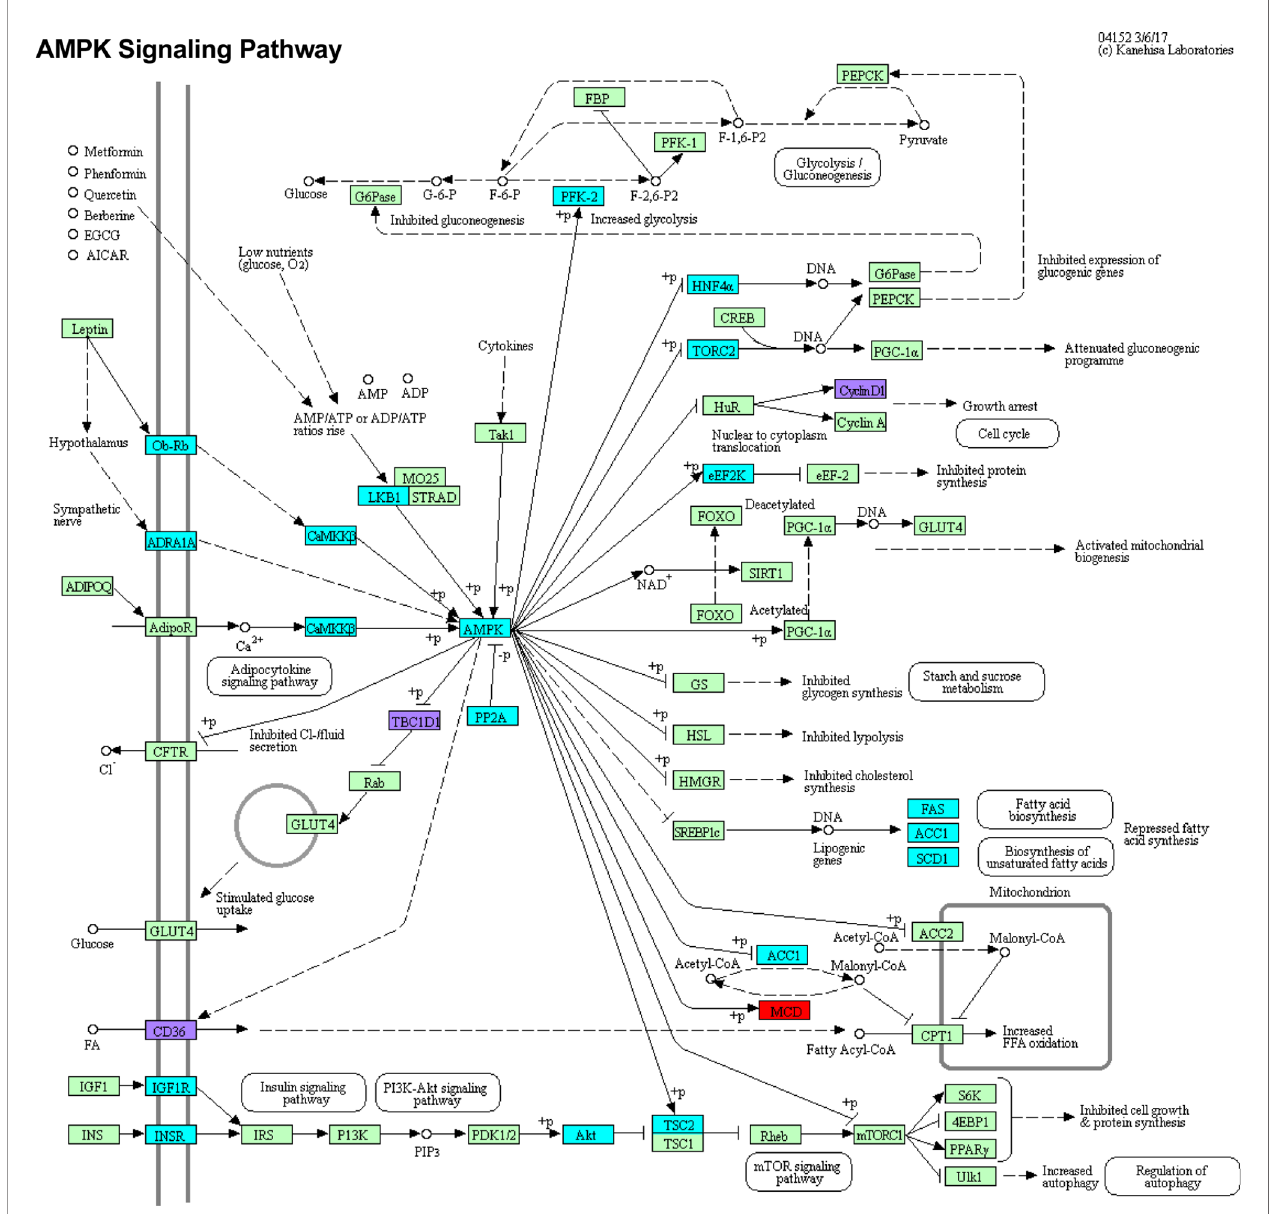
FIGURE 7 | DMRs DEGs and DE miRNA targets intersect at the AMPK signaling pathway. Genes that were differentially methylated, differentially expressed, or targeted by candidate miRNAs were subjected to functional enrichment KEGG analysis. These genes were most signi fi cantly associated with the AMPK signaling pathway. Genes which are only differentially methylated are highlighted in cyan. Genes which are only differentially expressed are highlighted in red. Genes which are differentially methylated, differentially expressed, and regulated by one or more miRNA are highlighted in purple. Light green boxes represent other pathway genes that were not found to be signi fi cantly in our